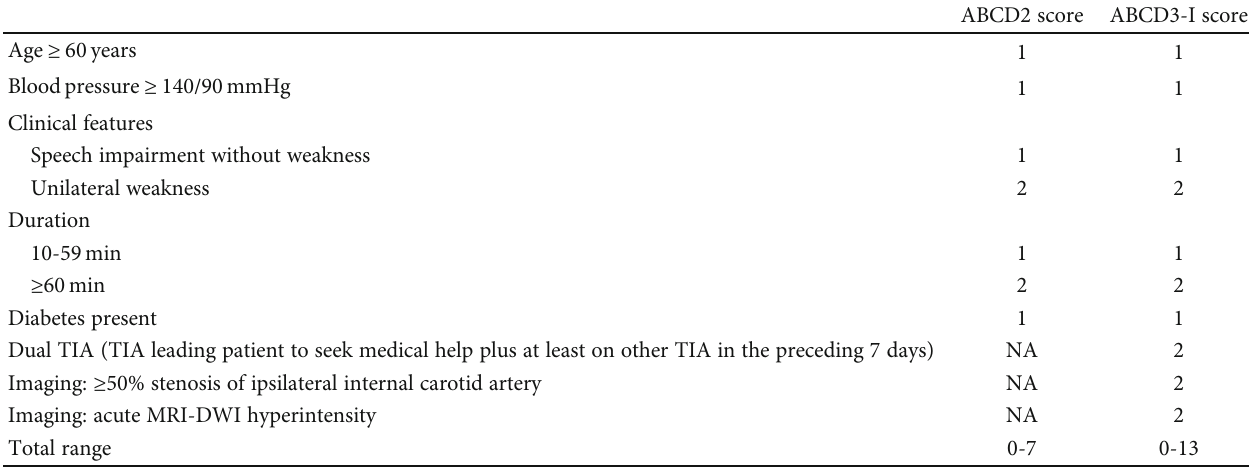
Table 1: ABCD2 and ABCD3-I